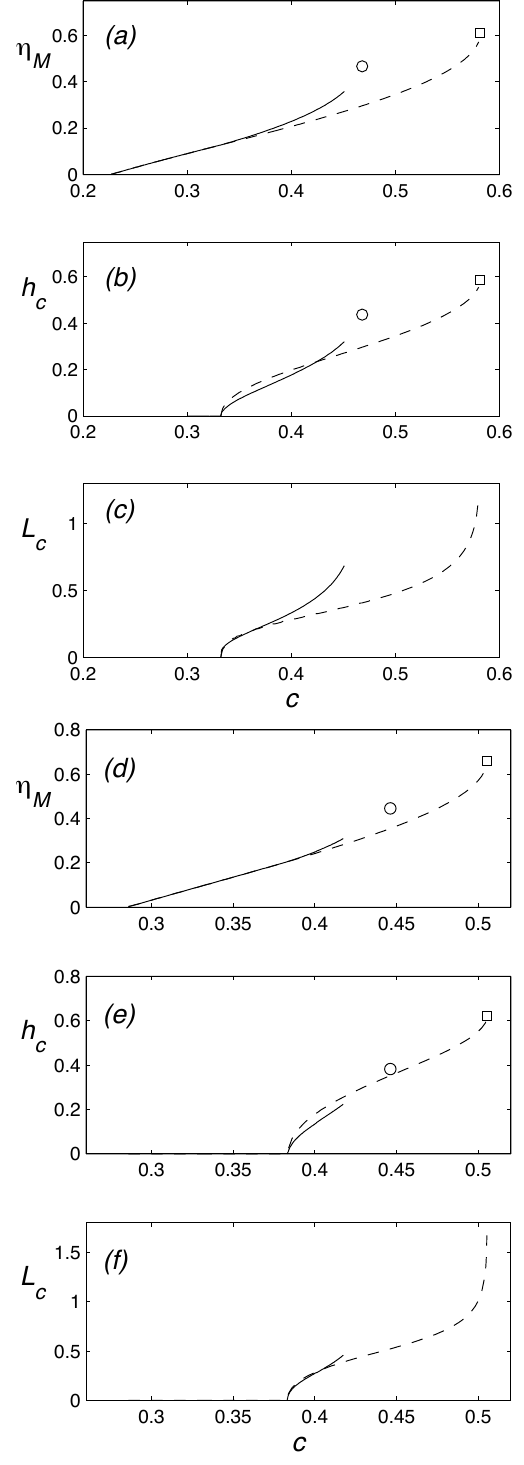
Fig. 8. The wave amplitude η M , core height h c , and core length L c vs. wave speed c from the stagnant-core DJL solutions are shown by the solid lines for s c =1 and λ = 8, (a) – (c) , and λ = 4, (d) – (e) . The open circles indicate the conjugate state solutions. The dashed lined and open squares show the same quantities from the extended- ¯ s DJL